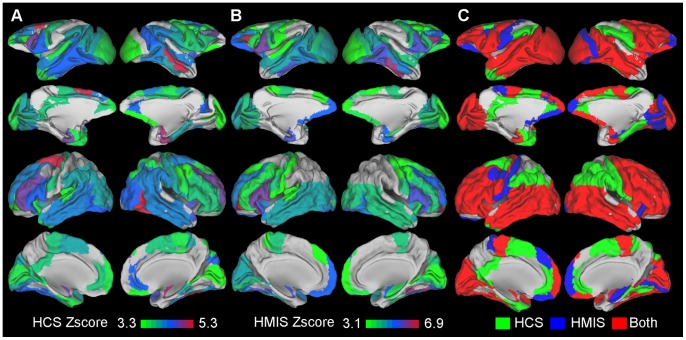
Renderings of the macaque and human regions exhibiting a significant HCS and HMIS index.A. HCS index B. HMIS index. In both panels only regions reaching significance are depicted (p<0.05 Bonferroni corrected). Colour coding denotes their corresponding z-score. C. Summary of results by colour coding the regions based on the preservation of both HMIS and HCS (red), only HCS (green), only HMIS (blue).